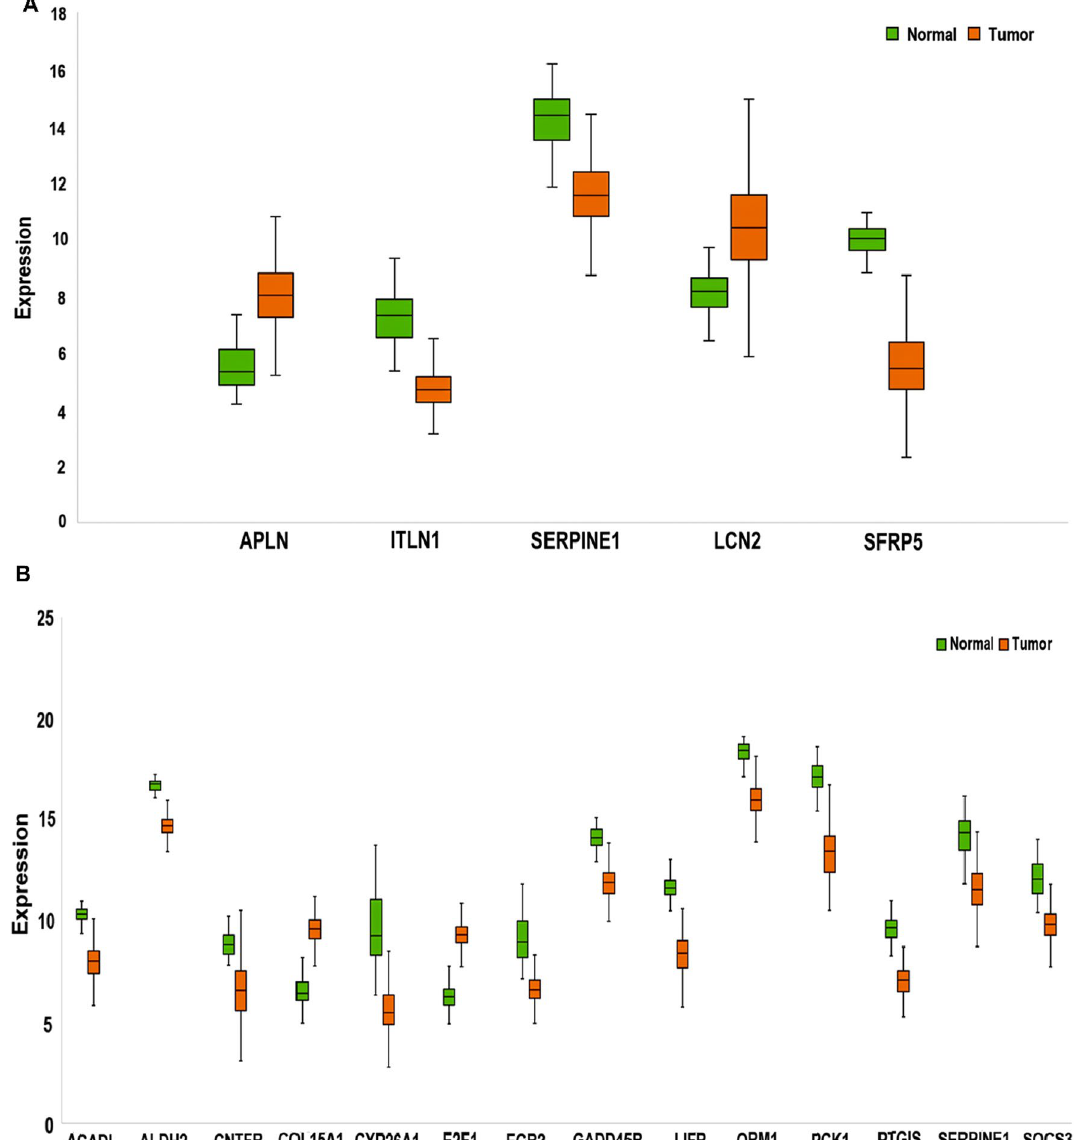
Fig. 1 Box-and-whisker plots displaying the expression distribution of A HCC-specific adipokines and B HCC-specific adipogenesis across TCGA-HCC cohort samples. Green- and orange-colored areas signify normal and tumor patient samples. The top and bottom of the boxes signify 75th and 25th percentile of distribution. Horizontal lines within the boxes represent the median values, while the axes end points are labeled by minimum and maximum